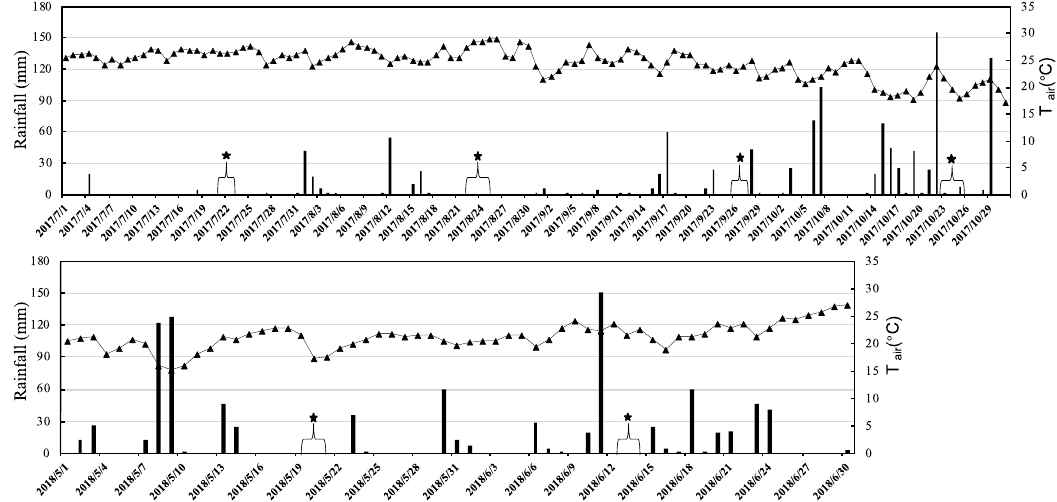
Figure A1. Daily rainfall (bars) and daily average air temperature (T air) (solid line) from June 2017 to July 2018. Pentagonal star represents the survey implementation day.